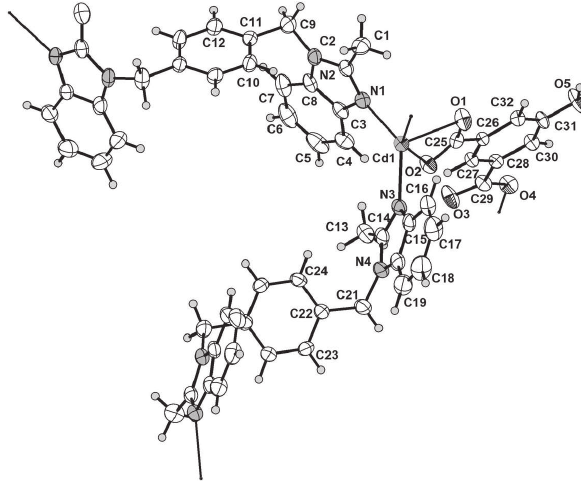
Tables 1 and 2 contain details of the measurement method and a list of the atoms including atomic coordinates and displacement parameters.